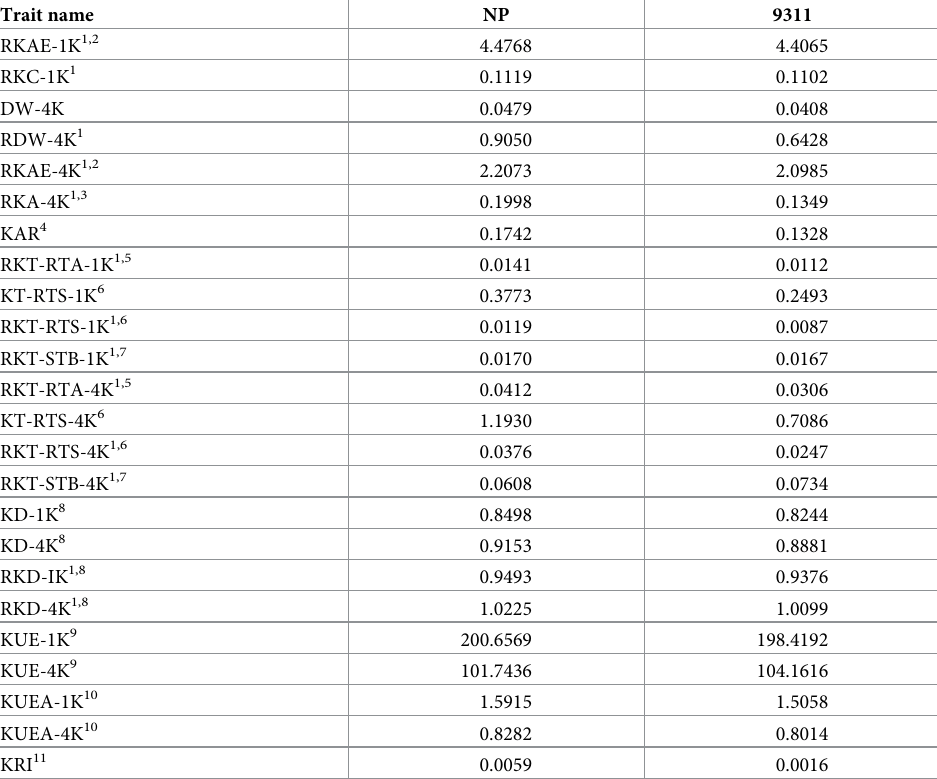
Table 3. Difference analysis of potassium-related traits of NP and 9311 treated with low potassium